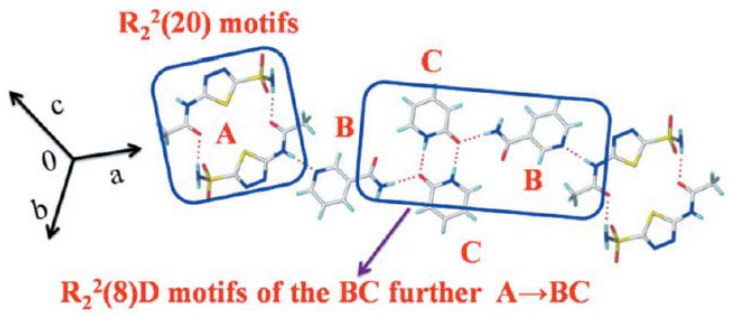
Figure 21. Synthons and R 22 (20) motifs and R 22 (8)D motifs observed in acetazolomide-nicotinamide-hydroxypyridine (1:1:1) ternary cocrystal [A—Acetazolomide; B—Nicotinamide; C—Hydroxypyridine] [Reprinted from [267] with permission of International Union of